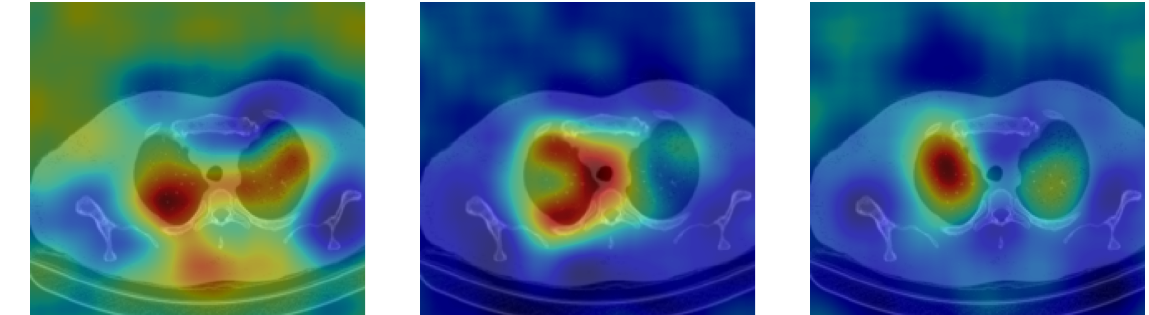
Figure 15. RISE heat map examples of normal slice image using the trained multi-tasks CNN architectures (ResneXt-50, Densenet-161, Inception-v3, and Wide-Resnet-50). The first example is shown in the first two rows, where the images represent the input slice image and segmented lung lobes results, followed by the heat maps of ResneXt-50, Densenet-161, Inception-v3, and Wide-Resnet-50, respectively. The second example is in rows 3 and